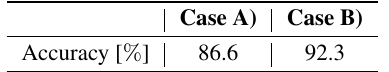
Table 2. Classification results using the original synthetic labeled images.